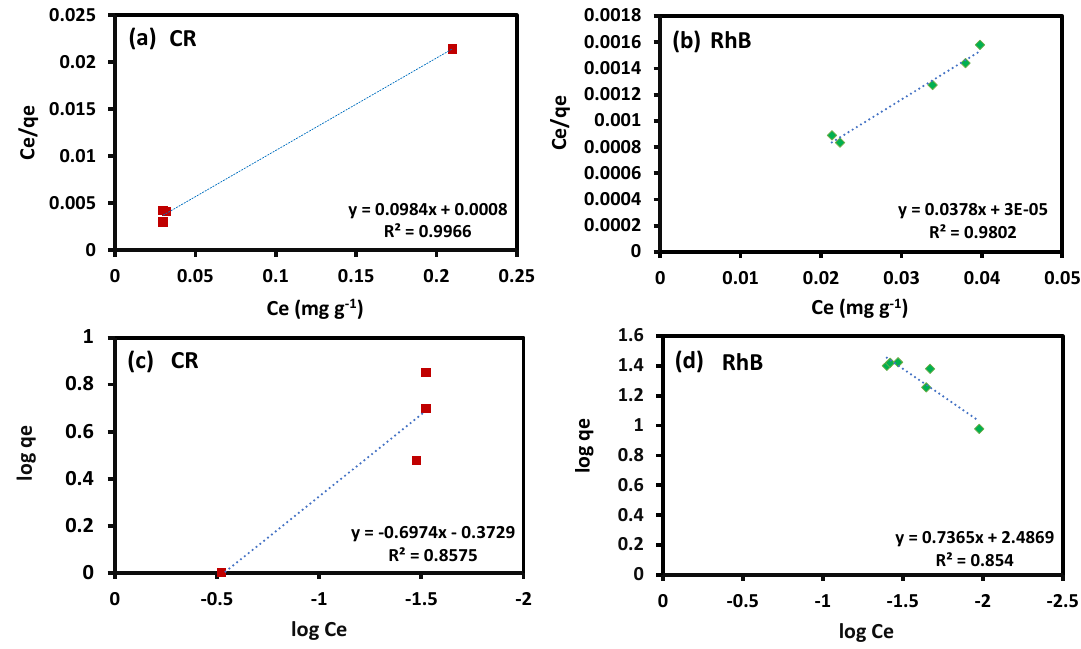
Figure 8. Adsorption isotherms: Langmuir model of ( a ) CR dye; ( b ) RhB dye and Freundlich model for the adsorption of ( c ) CR dye; ( d ) RhB dye by PTFAC (reaction conditions: T= 298 K, pH = 2.0, C o = 25 mg L −1 , mass = 0.15 g, V = 20 mL, shaking time = 120 min). Table 2. Adsorption isotherm parameters calculated for RhB and CR dyes adsorbed by PTFAC*. Adsorption Isotherm